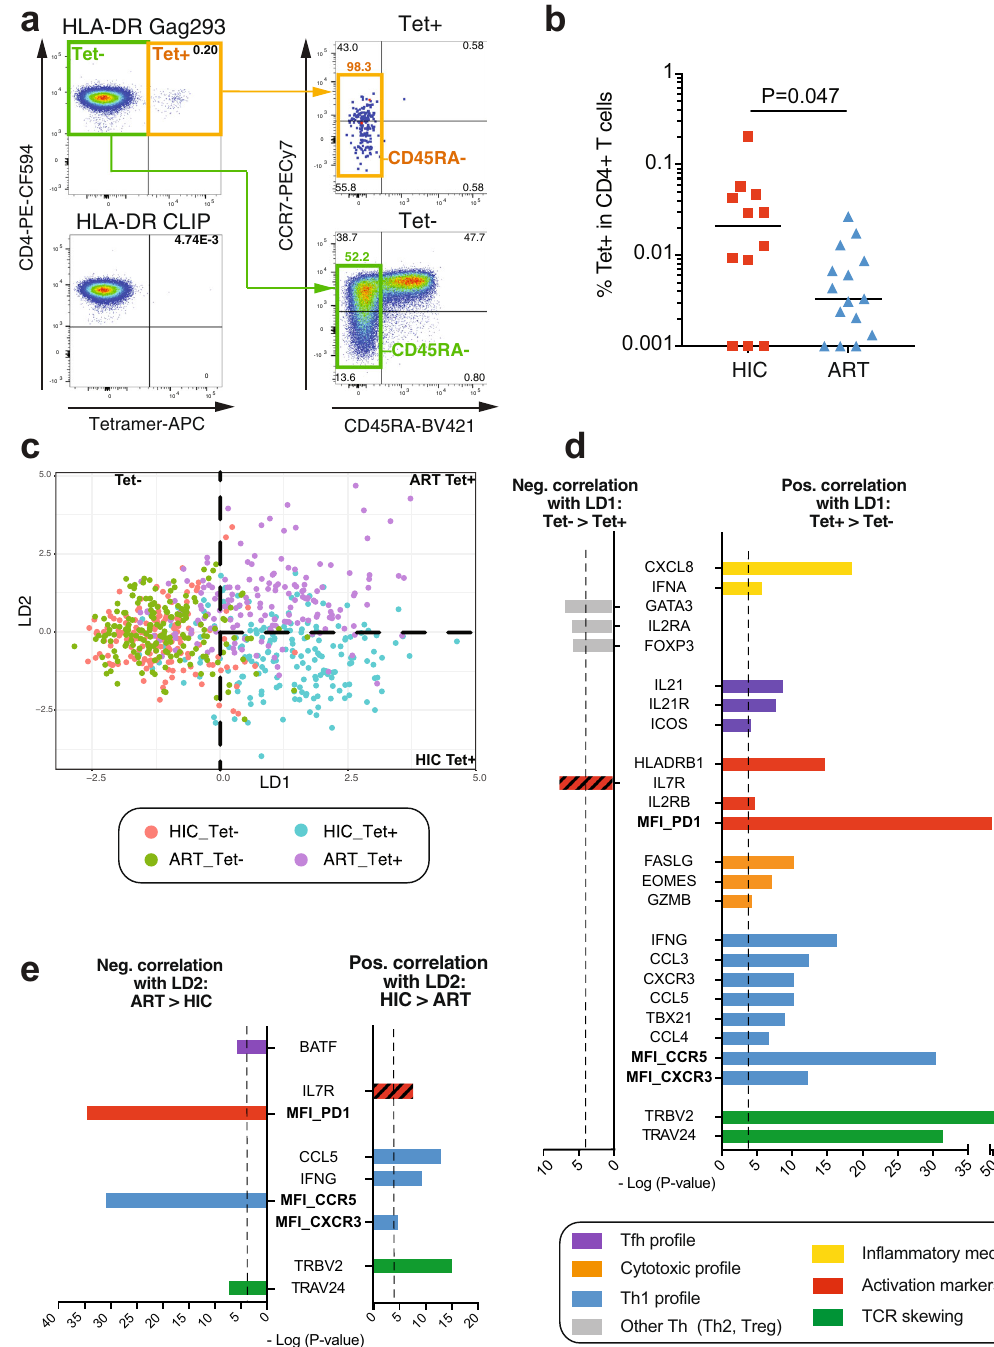
Fig. 1 Dominant Th1 differentiation pattern in Gag293-speci fi c cells of controllers. a Example of MHC II tetramer labeling in controller CD4 + T cells, with a Gag293-loaded tetramer (top left) compared to a CLIP-loaded control tetramer (bottom left). The frequency of CD45RA − memory cells is increased in the tetramer-positive (Tet + ) population (right). b Percentage of Gag293-speci fi c cells in CD4 + T cells of controllers (HIC, n = 12) and treated patients (ART, n = 15). Medians were compared with the Mann-Whitney test. c Distribution of n = 700 single CD4 + T cells by linear discriminant analysis (LDA). d , e List of variables that are most signi fi cantly correlated with the LD1 ( d ) or LD2 ( e ) discriminant directions de fi ned in the LDA, with a threshold P -value<10 − 4 . P values were computed for the Pearson correlations, without corrections for multiple comparisons. Genes are reported in plain text while mean fl uorescence intensities (MFI) of proteins are reported in bold. Variables are color-coded according to their implication in T cell differentiation pathways (e.g., Th1 variables in blue). The bar for IL7R is hatched because this marker decreases upon activation. Source data are provided as a Source Data fi Dominant Th1 differentiation pattern in Gag293-speci fi c cells according to the group of patients, with group separation CD4 + T cells of controllers . Examining the top variables visible mainly among Tet + cells. Thus, differences between the that correlated most signi fi cantly with LD1 (p < 10 − 4 ; Fig. 1d) HIC and ART patient groups appeared to be driven by HIV- speci fi c cells. indicated that Tet + cells were primarily characterized by the